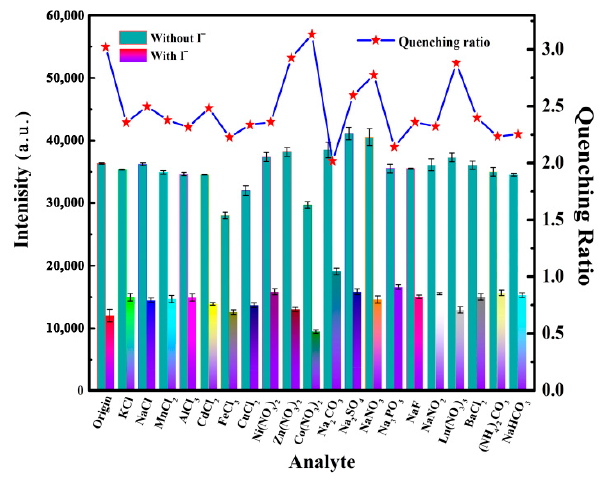
Figure 7. Changes of fluorescence intensity of Ag + UiO-66-(COOH) 2 towards various analytes (1 × 10 − 4 M) before I − addition (cyan column) and after I − (10 mg/L) addition (multi-color column).